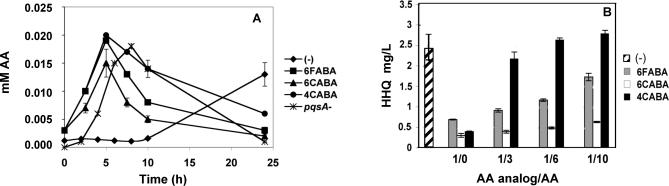
AA Analogs Compete with AA for the PqsA Active Site(A) The AA analogs do not perturb AA accumulation. Intracellular AA concentrations (mM) were determined for PA14 cells grown minus or plus 1.5 mM 6FABA, 6CABA, or 4CABA, and for pqsA
− mutant cells.(B) Exogenous AA partially overcomes AA analog inhibition of HHQ synthesis in PA14 cells. Increasing concentrations of AA were added to cultures grown in 0.125 mM 6FABA, 0.75 mM 6CABA, or 0.125 mM 4CABA, which reduced HHQ production by 75% in supernatants of OD600 = 4 cell cultures. The competing AA concentrations were 0, 3, 6, and 10 times that of each AA analog.